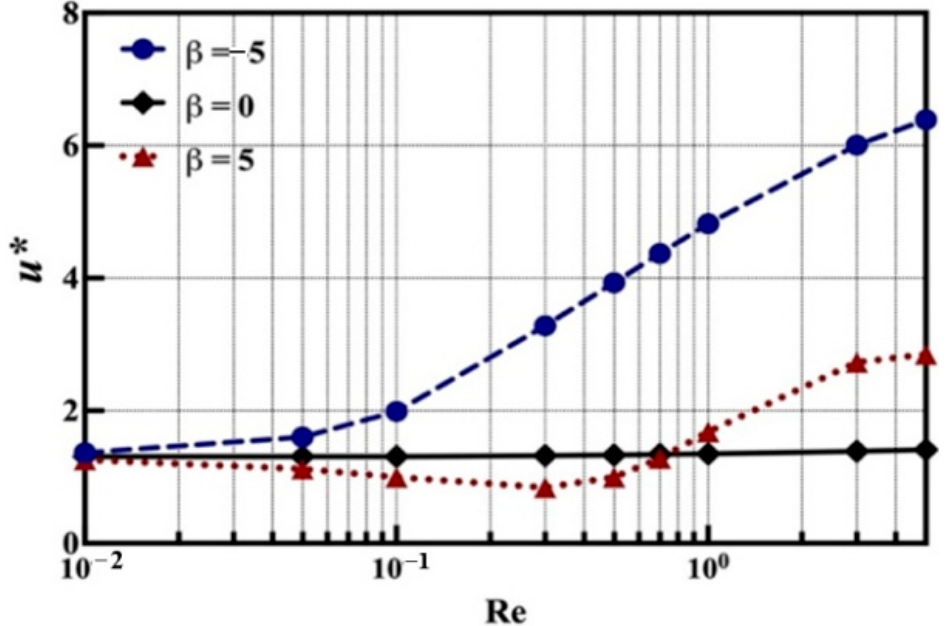
Figure 8. Relationship between u * and